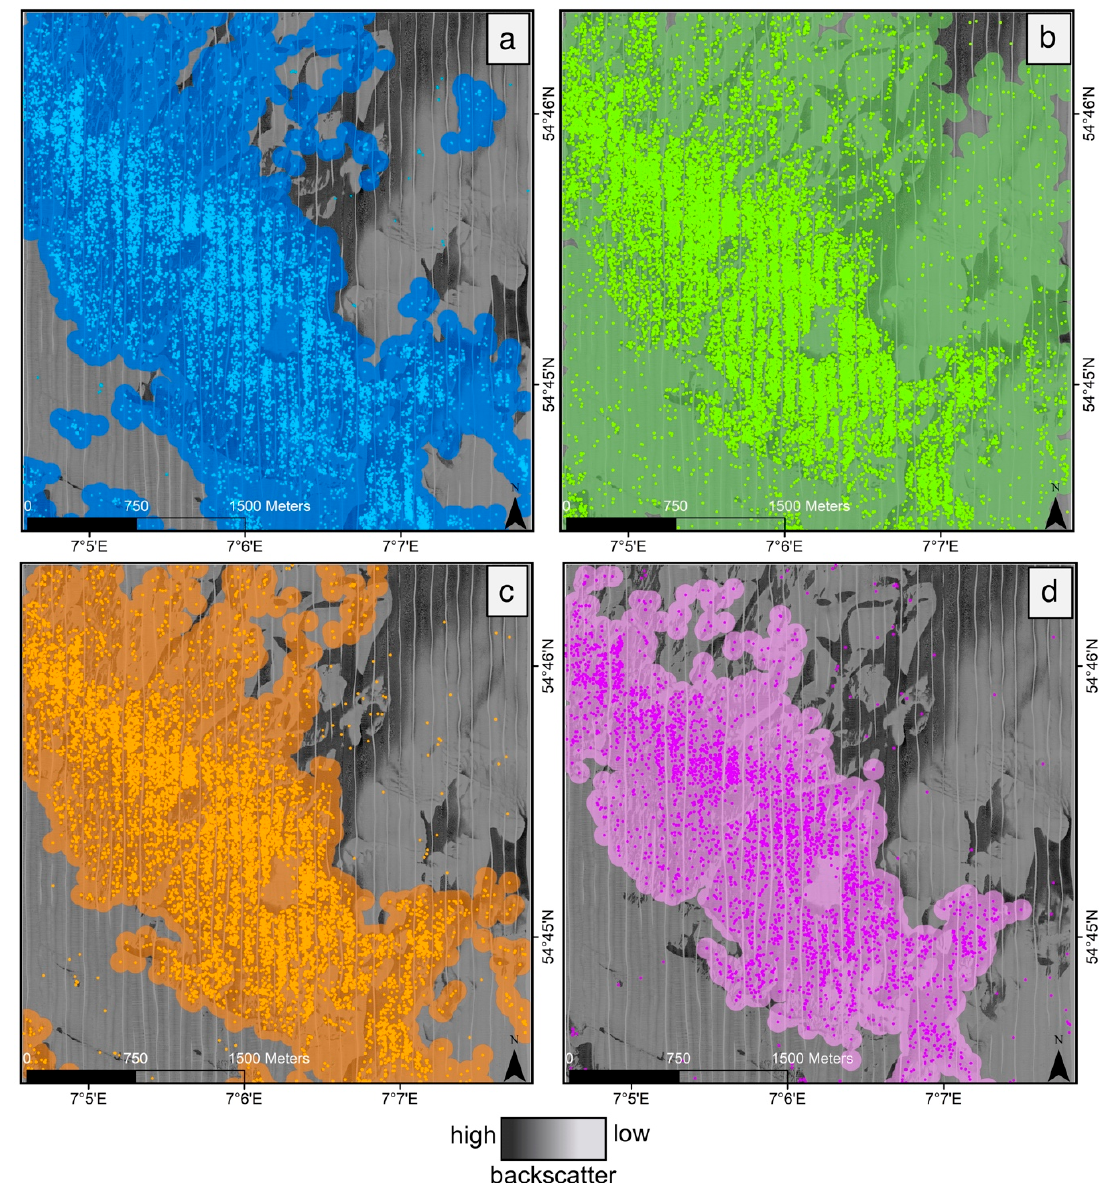
Figure 7. Demarcated geogenic reef area and identified stones (points) on an SSS mosaic (25-cm resolution) with different methods: ( a ) manually, automatically on an SSS mosaic with 64 grey values and a detector threshold value of 6 ( b ), 12 ( c ) and 20 ( d ). Table 5. Proportion of the manual reef area shared with the model-predicted one after the method proposed by [23] under different frame conditions. Color scale indicates high values in green and low values in red. The predicted reef area [km 2 ] not shared with the manually derived one (= 8.675 km 2 ) is given in parentheses. Grey Values